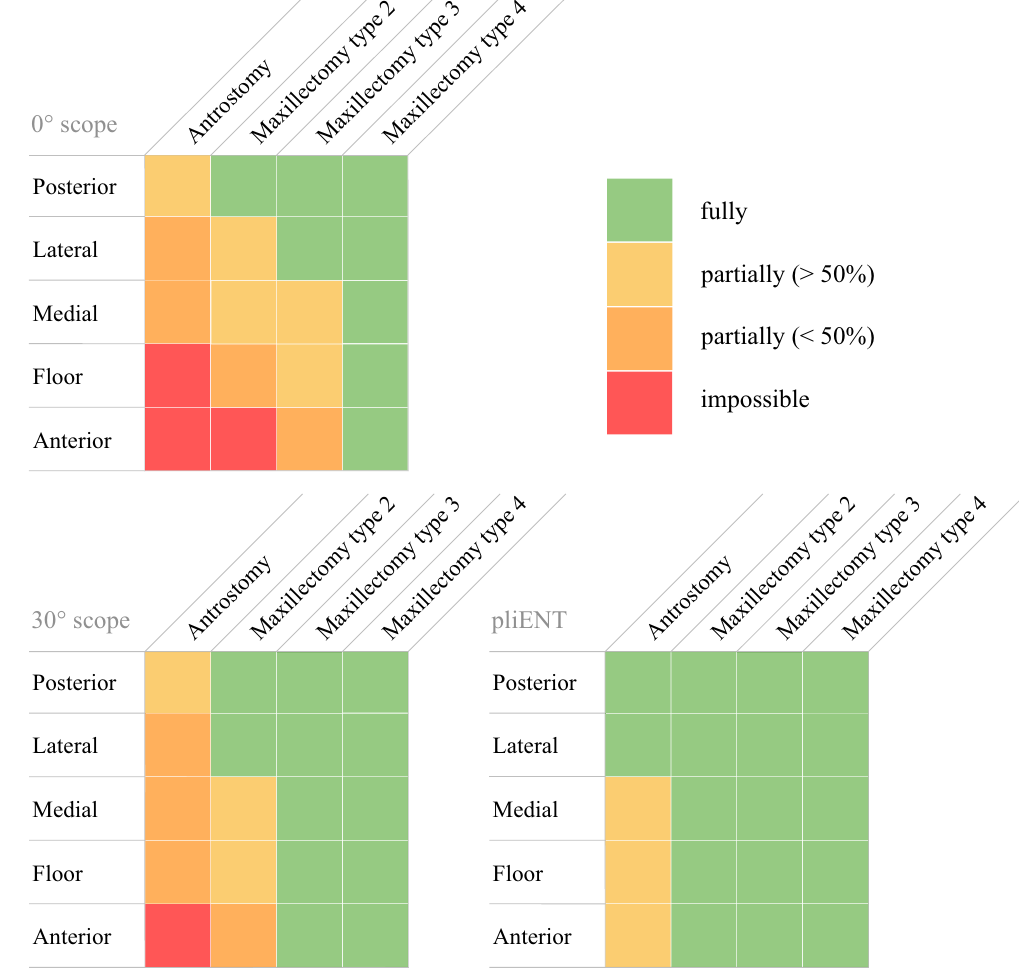
Figure 4. Visibility reported by the surgeons: full, partial or no visualization of the maxillary sinus walls with the 0° and 30° rigid endoscopes and the PliENT endoscope for each considered enlargement